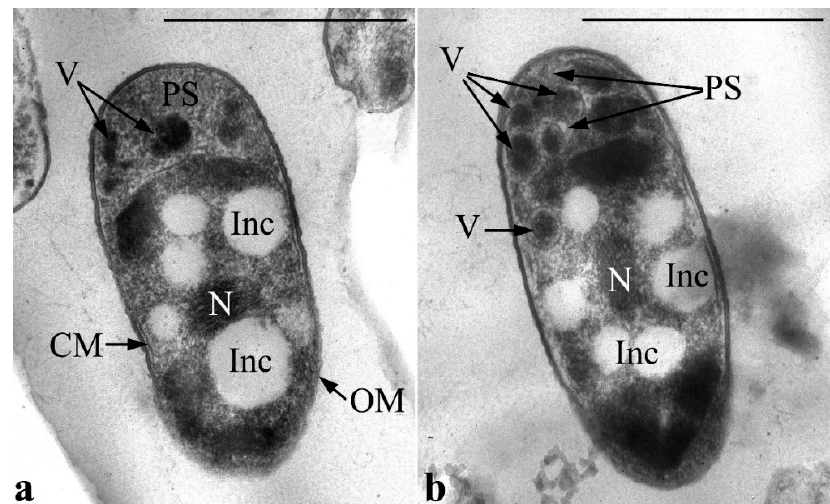
Figure 7. Transmission electron microscopy. Ultrathin sections of P. putida Ch2 cells during growth in a liquid MS1 medium with glyphosate, the 1st day ( a,b ). Designations: OM—outer membrane; CM—cytoplasmic membrane; V—vesicles; Inc—PHA inclusions; N—nucleoid; PS—periplasmic space. Bar = 1 μ m.